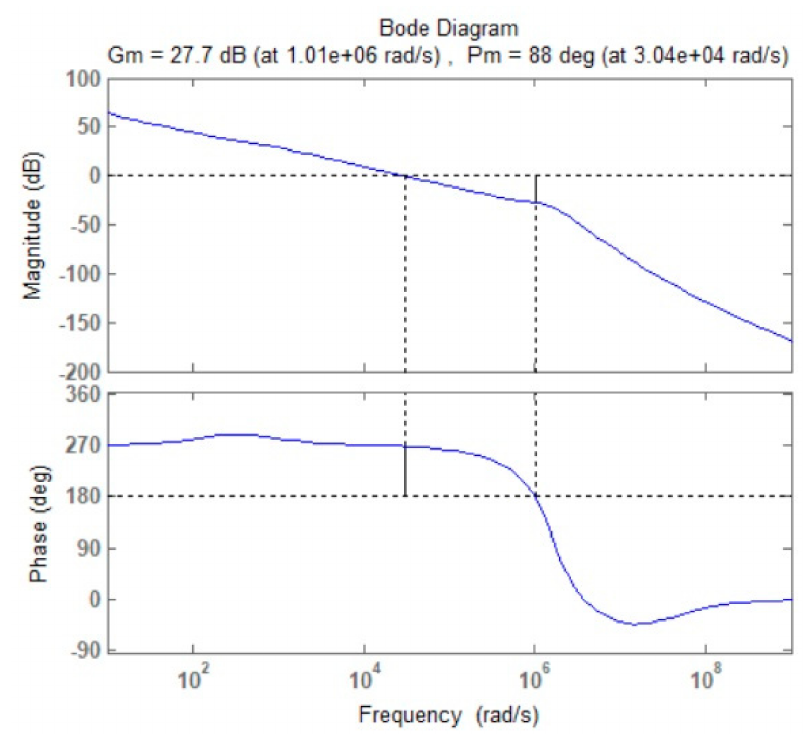
Figure 13. Bode diagram of channel 3 with type two compensator.